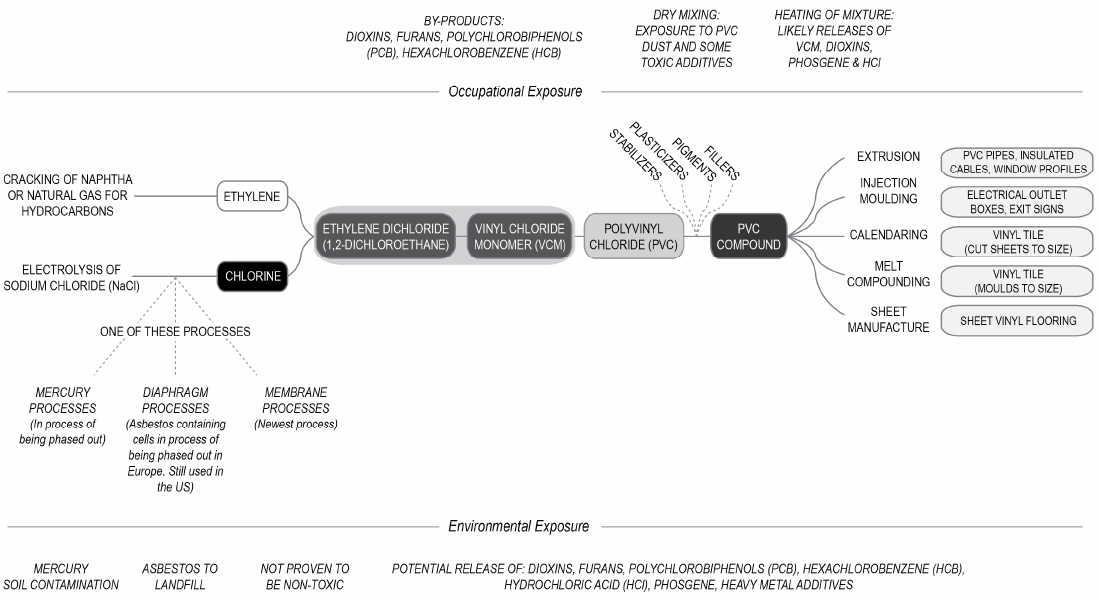
Figure 2. Diagram summarizing the most common manufacture of polyvinyl chloride (PVC) process showing the likely health issues in different stages. (Diagram: Lydia Hamer and Emina Kristina Petrovi ć .)